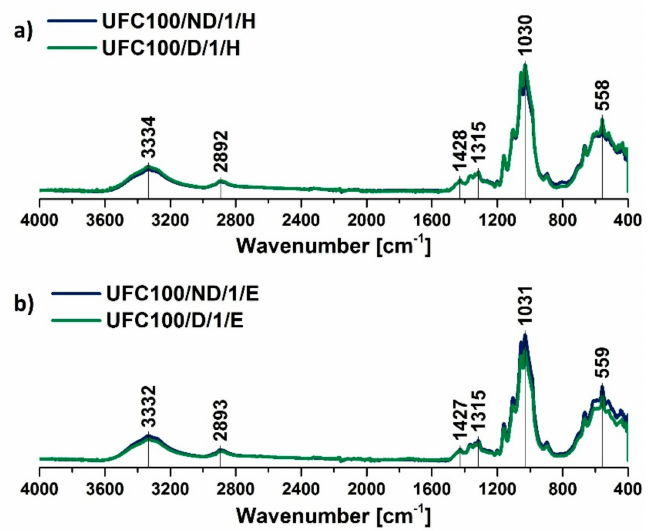
Figure 4. FT-IR spectra of solvent treated cellulose fibers: ( a ) solvent exchange to hexane, ( b ) solvent exchange to ethanol. Characteristic absorption bands: 3334 cm − 1 (O–H, water), 2894 cm − 1